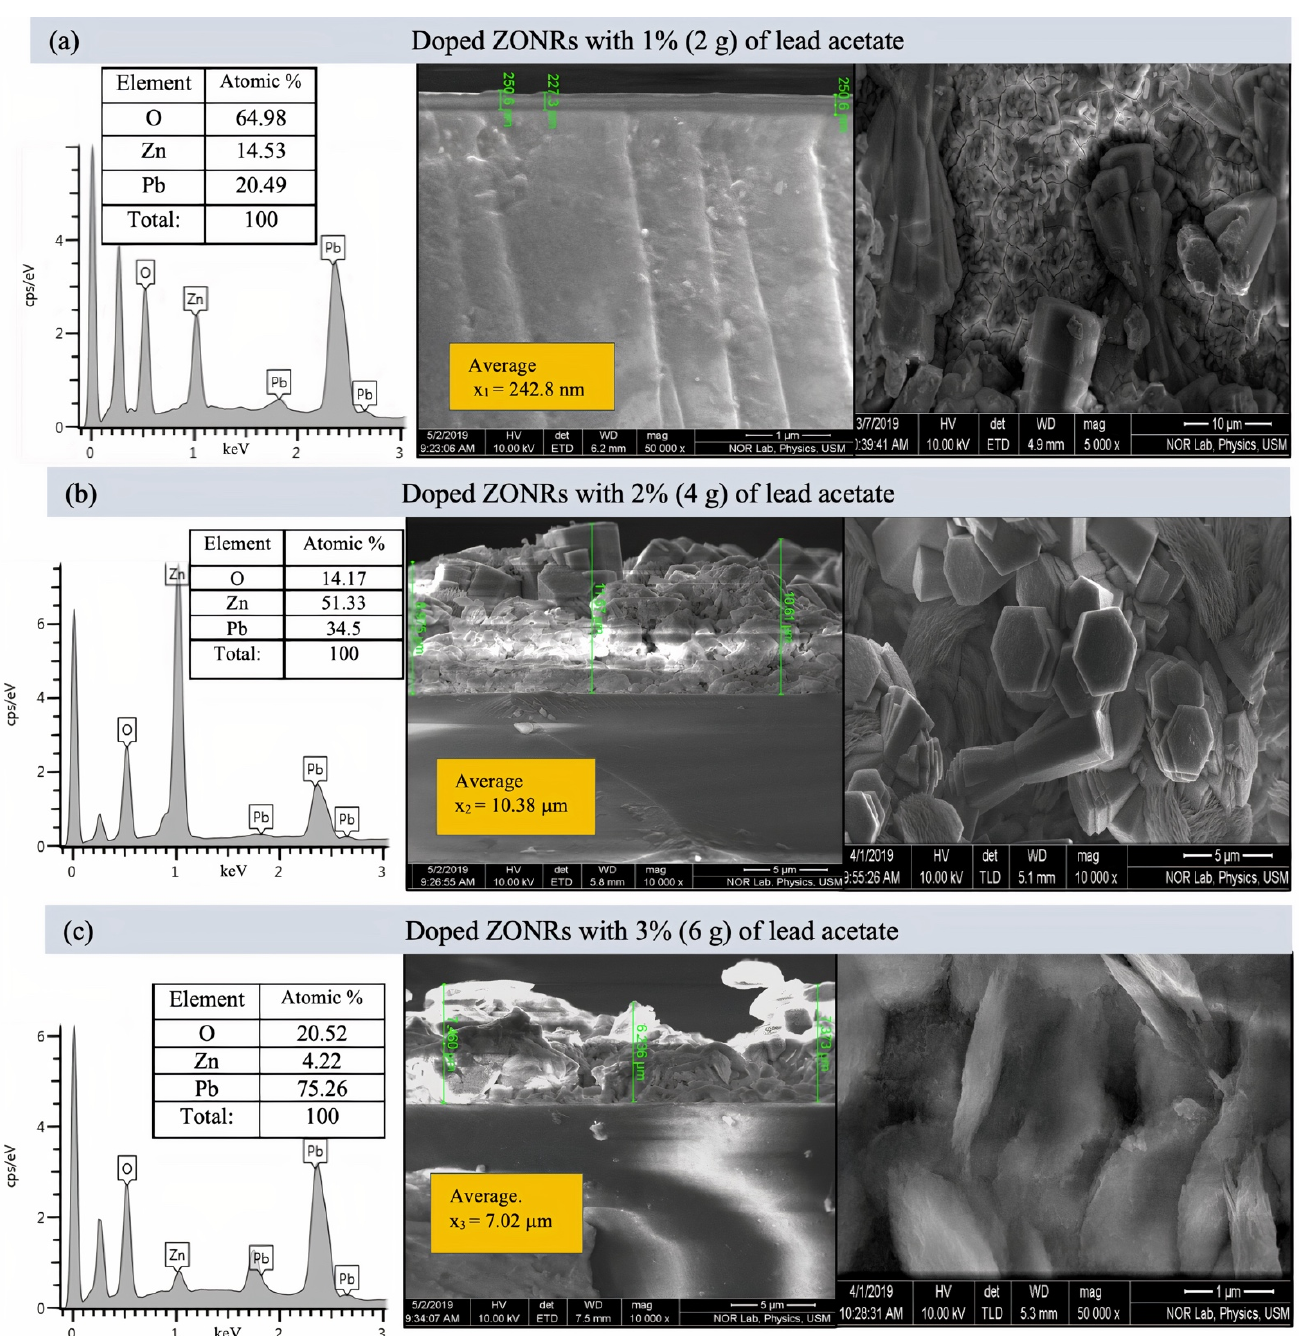
Figure 5. Cross-sectional FESEM images ( right ) and EDX spectra ( left ) of the ZONRs-TFs doped with 1–3 wt.% of LA, Inset: EDX Atomic% of detected trace elements.